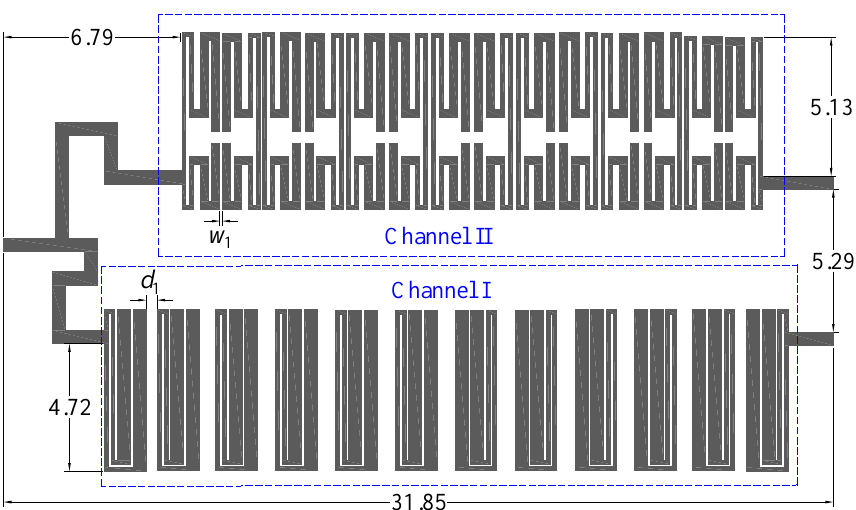
Figure 10. The layout of the HTS diplexer.